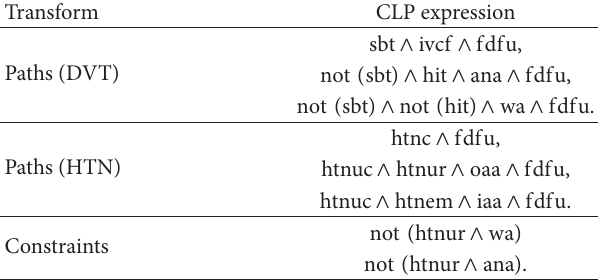
Table 2: CLP model for combining clinical